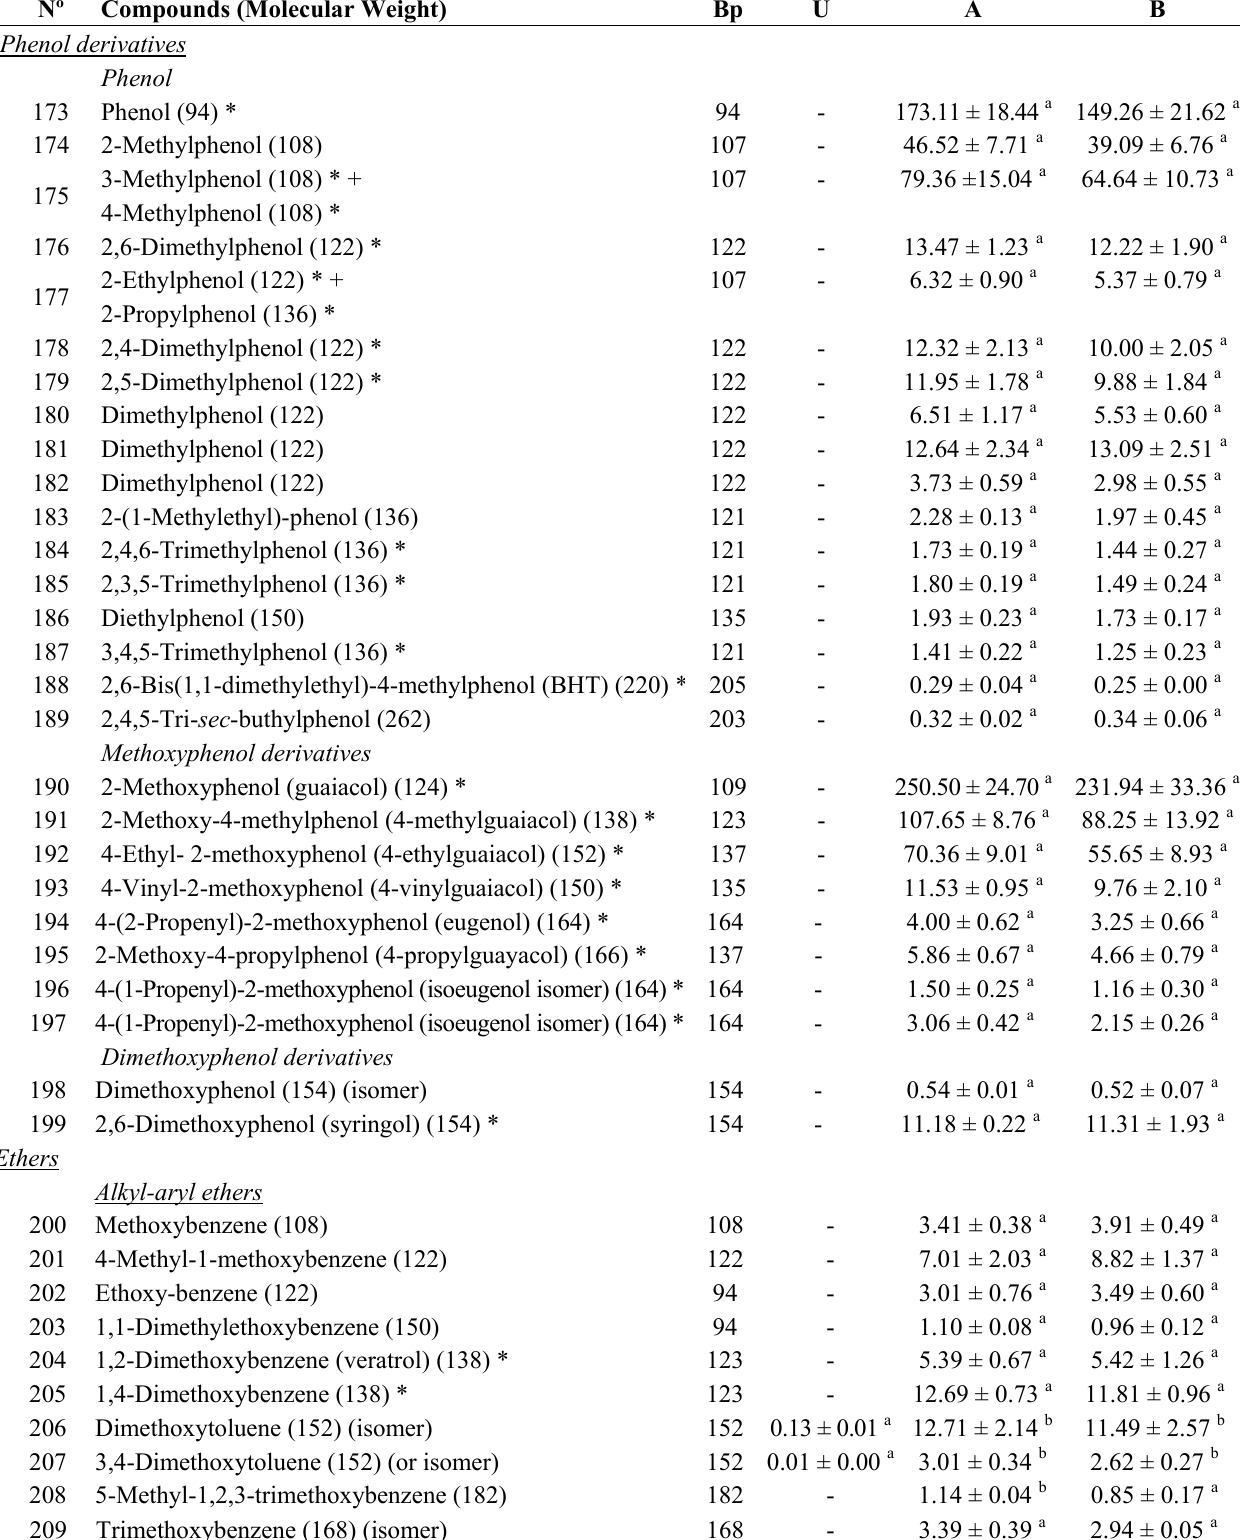
Table 5. Phenol derivatives and ethers detected in the headspace of the exterior region of unsmoked (U) and smoked (A and B) Herreño cheeses studied, together with their molecular weight, the base peak of their mass spectra (Bp), their abundance, expressed as average area counts of their mass spectra base peak divided by 10 5 , and standard deviation a